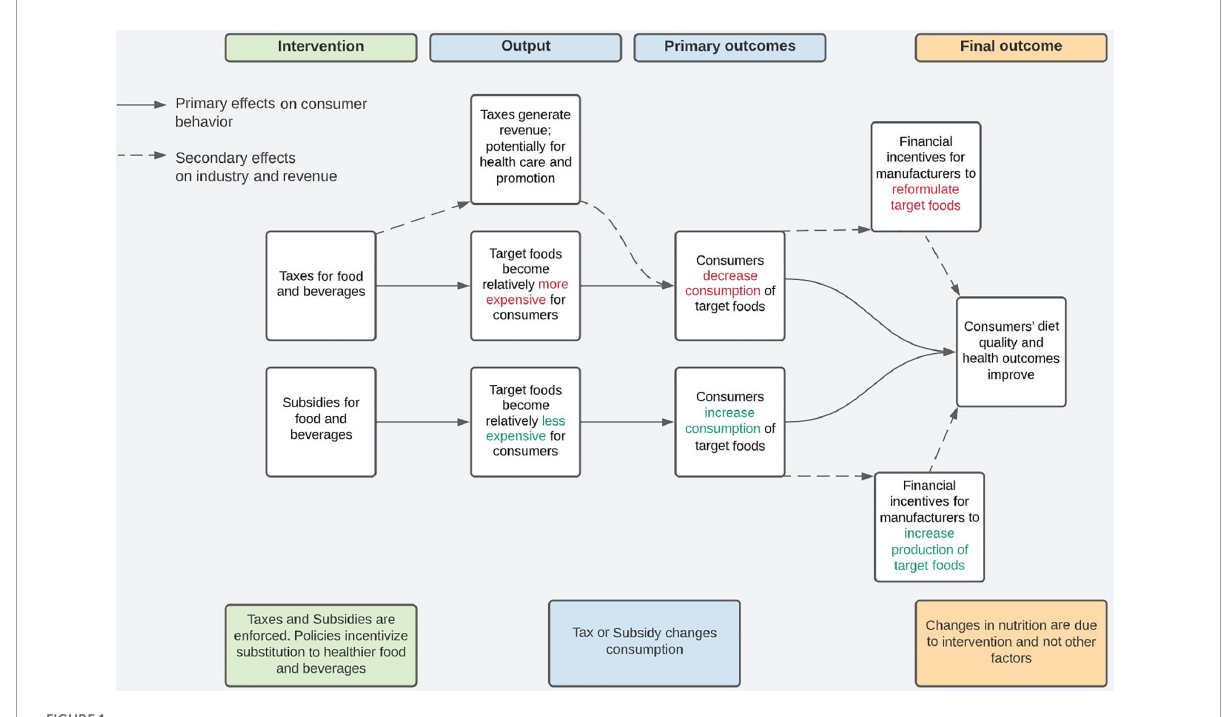
FIGURE1 Fiscal policy theory of change, World Health Organization (4).